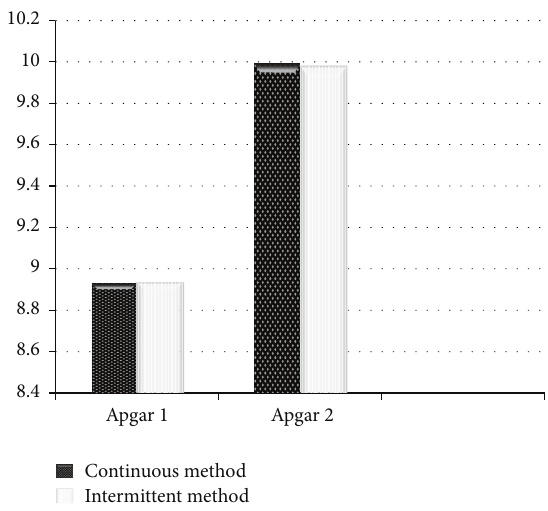
Figure 2: Comparison of Apgar in the first and fifth minutes between two